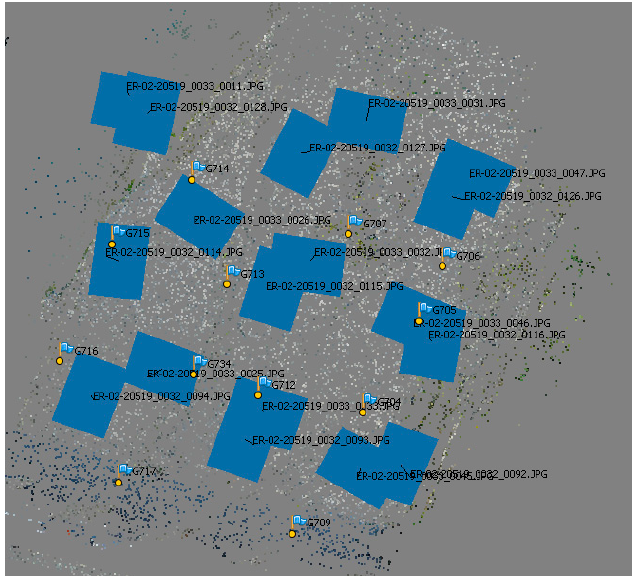
Figure 4. The 18-images pre-calibration block extracted from the two eBee flights (9 from each) and the location of the 12 GCP used in the pre-calibration adjustment (see also light blue dots in Figure 1). O2 . To assess the accuracy of the Phantom4 single strip at 30 m oriented with GCP .